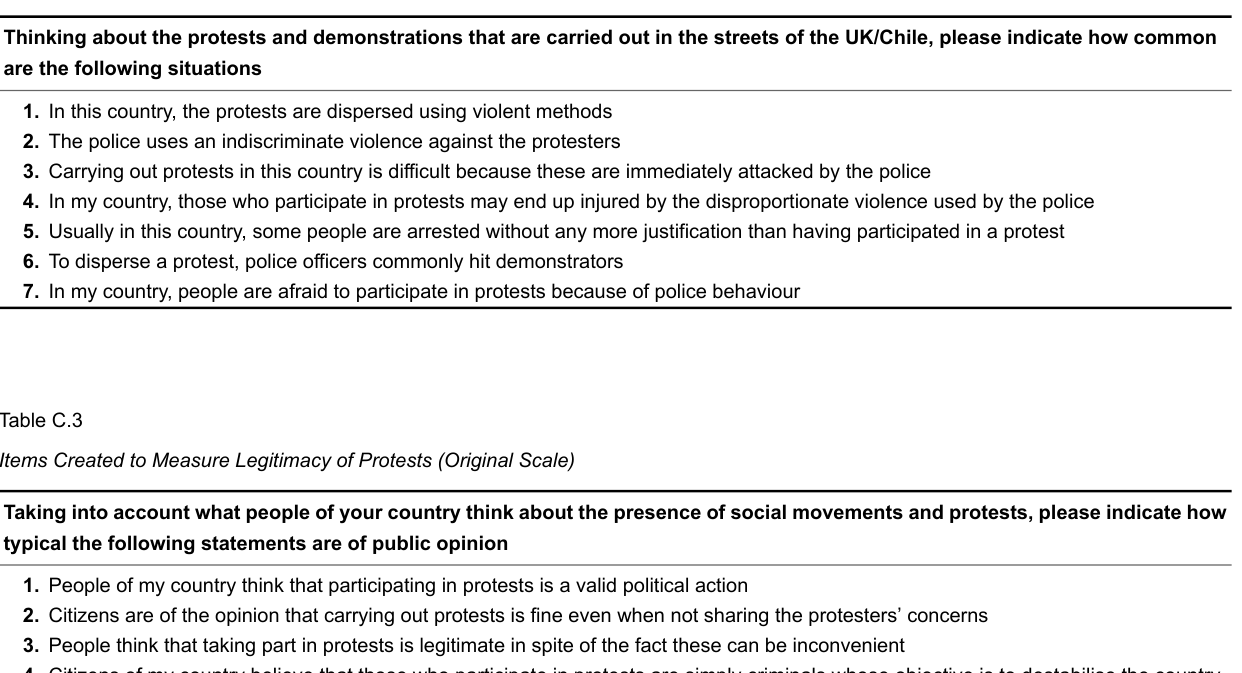
Items Created to Measure Perceived Repression